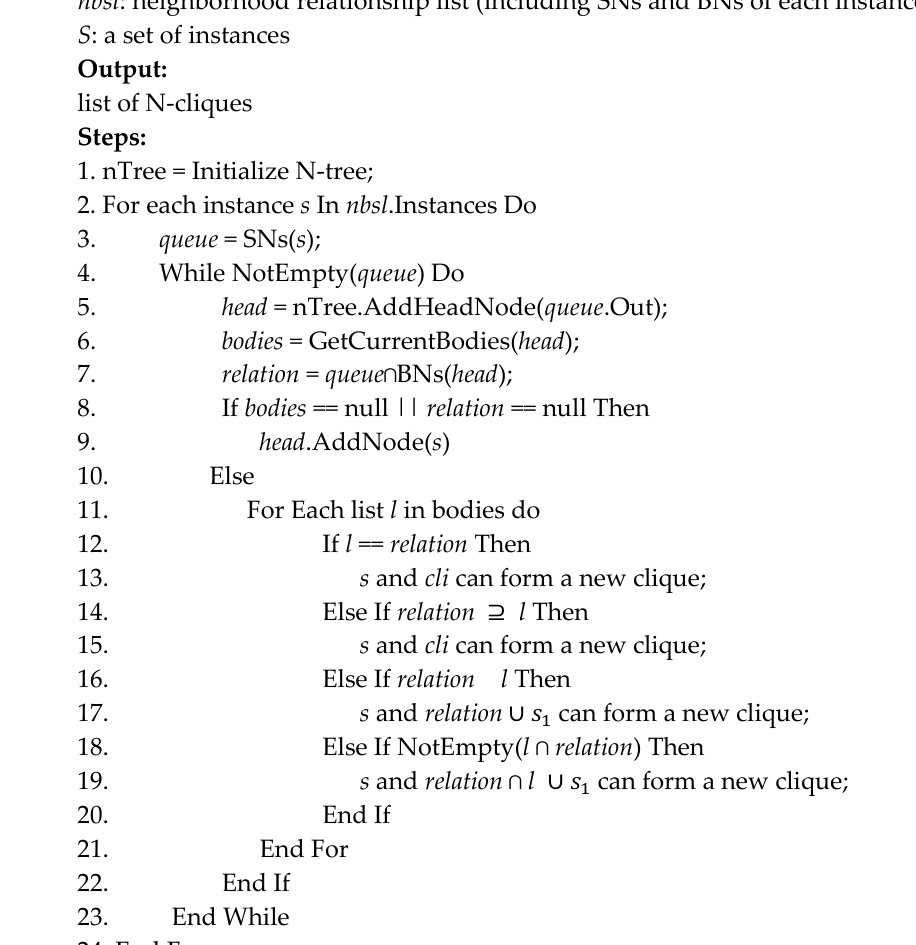
In a clique cli = {   ,   ,…,   }, for any instance for   of cli , {   ,   ,…,   } is